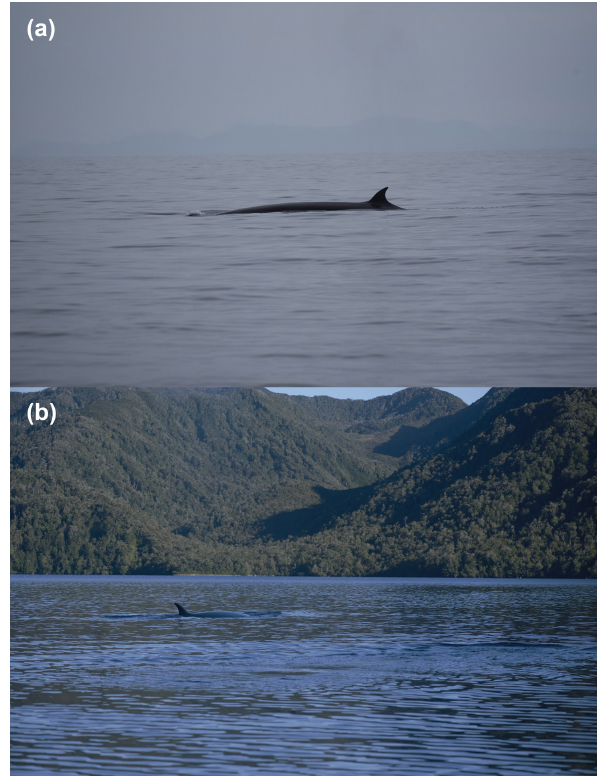
Figure 2. Photographed sei whale at Penas and Tres Montes gulfs on (a) 7 May 2016 (photo by Katie McConnell) and (b) 10 May 2017 (photo by Keri-Lee Pashuk).